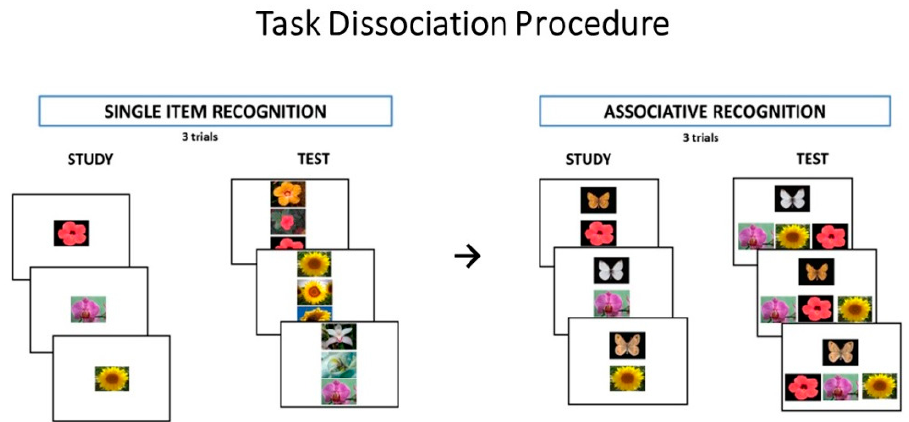
Figure 2. Examples of items in the Task Dissociation Procedure. The experimental setting included two memory tasks: the single-item recognition task and the associative recognition task. Each task consisted of three learning trials. In the study phase of the single item recognition task, participants were presented with 9 flowers. Immediately after the study phase, 9 triplets of flowers were presented; each triplet consisted of a previously studied flower (target item) and two new flowers presented vertically. The associative recognition task was administered immediately after the single item recognition task. The study phase consisted of the presentation of 9 pairs, each including a butterfly and a flower photo. Each recognition item included a butterfly and a flower triplet composed of the flower that had been presented together with the probe butterfly during the study phase, and two others that had been presented together with two different butterflies during the study phase. The participants were requested to indicate the flower that had been presented with the butterfly during the study